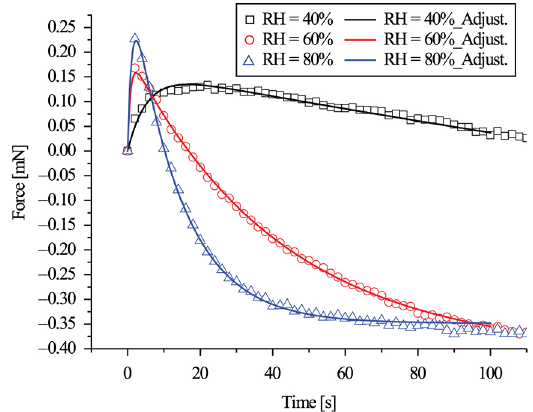
Figure 5. Electromechanical response of N117 based IPMC with Na + activated by U=2.0V conditioned in environments with different relative